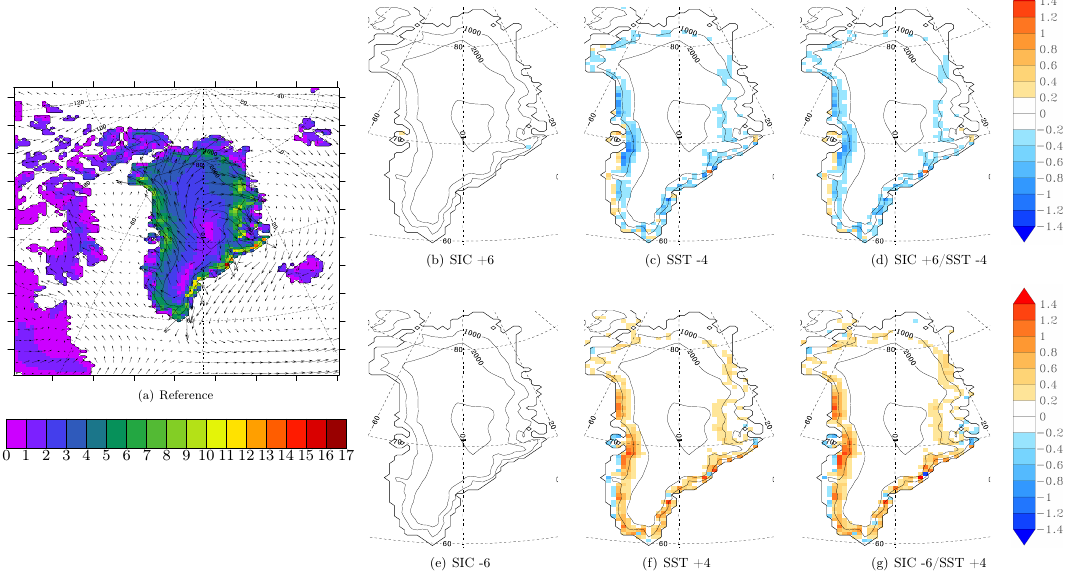
Figure 8. JJA mean wind speed (ms − 1 ) for the reference run (a) over 2007–2012. Difference in the JJA mean wind speed (ms − 1 ) between (b) SIC + 6, (c) SST − 4, (d) SIC + 6/SST − 4, (e) SIC − 6, (f) SST + 4, (g) SIC − 6/SST + 4 experiments and the reference run.